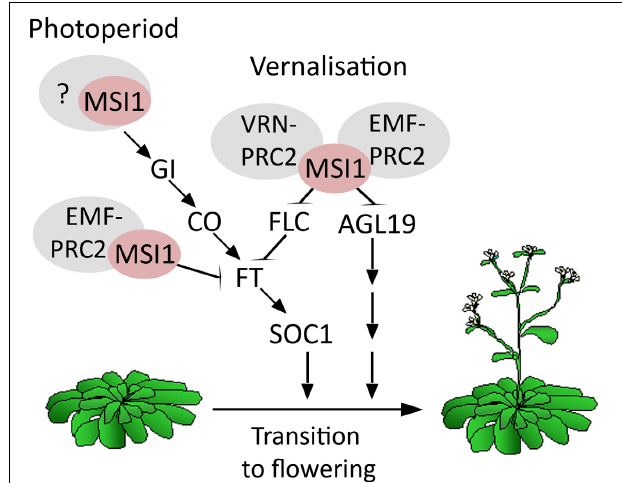
FIGURE 5 | Model of MSI1 function in flowering time control. Scheme of the different pathways MSI1 is acting in to affect flowering time. First, MSI1 represses flowering via its functions in the EMF-PRC2-complex to represses AGL19 prior to vernalization and FT prior to photoperiodic